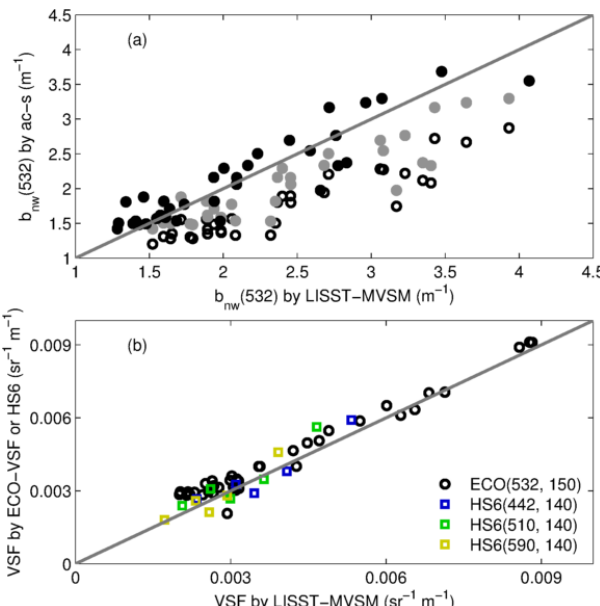
Fig. 3. Intercomparison between different instruments measuring scattering properties. (a) The comparisons of b nw (532) estimated from the ac-s and LISST-MVSM. Two scattering corrections were progressively applied to (1) a nw (532) to correct for scattering at angles from 41 ◦ to 180 ◦ that ac-s a-meter could not measure and (2) the LISST-MVSM based b nw (532) with integration only down to 0.93 ◦ to match the acceptance angle of ac-s c-meter. Open cir- cles: neither correction was applied; grey circles: the 1 st correction; black circles: both corrections. (b) The comparison of the LISST- MVSM β(λ , θ ) with ECO-VSF data measured at 150 ◦ at 532nm and with HydroScat-6 at 140 ◦ for three wavelengths of 442, 510 and 590nm. For comparison with HydroScat-6 data, the spectral VSF values at the corresponding wavelengths were